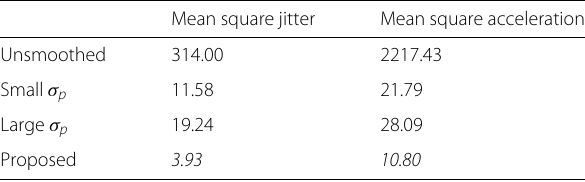
Table 1 Numerical comparison between different motion smoothing algorithms for the synthetic camera motion Mean square jitter